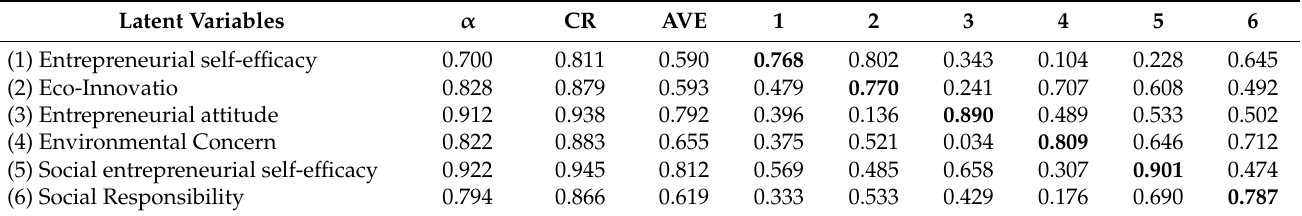
Table 1. Composite reliability, average variance extracted, correlations, and discriminant validity